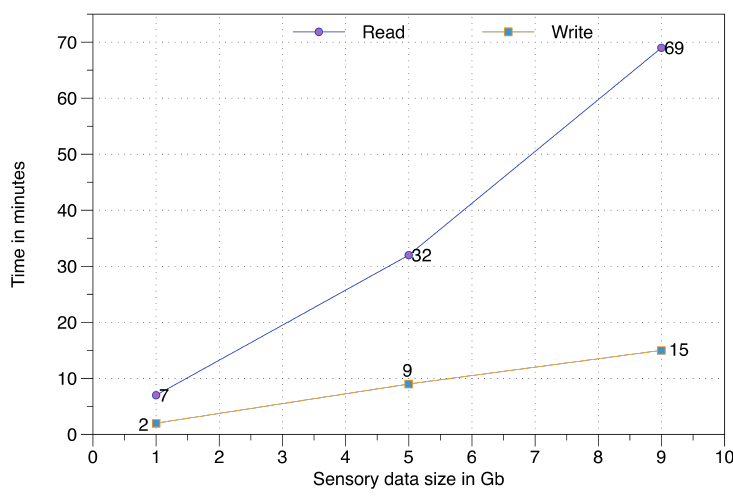
Figure 18. Read and write time over big data storage. Table 2. Query execution